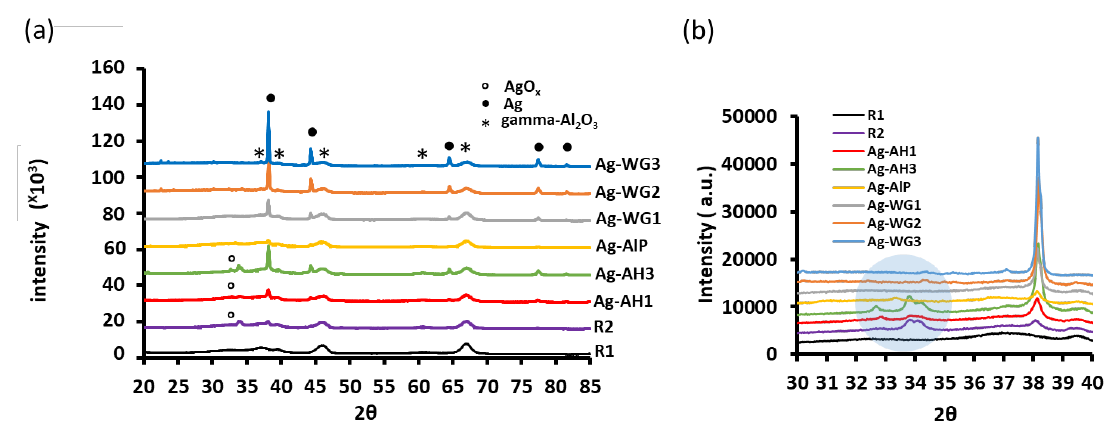
Figure 6. ( a ) Powder XRD patterns of the Ag-based catalysts in this study and the alumina reference. ( b ) Enlargement of the region in panel (a) where silver oxide peaks were observed, as highlighted by the blue circle. For more details about the catalysts, see Table 1.